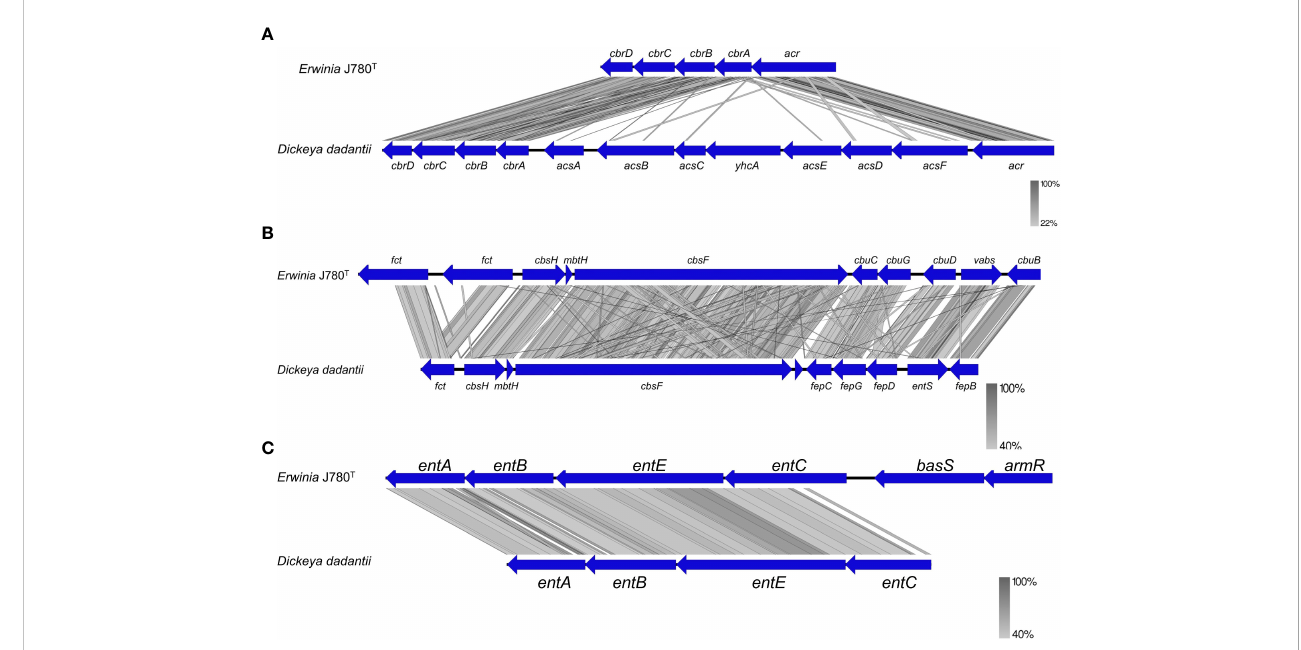
FIGURE 4 The comparison of siderophores genes between E. sorbitola sp. nov. (J780T) and Dickeya dadantil. (A) The comparison of achromobactin gene clusters; (B) the comparison of chrysobactin gene clusters; (C) the comparison of enterobactin gene clusters. The proposed gene nomenclature is shown above the corresponding ORFs. All the fi gures were compared using BlastX and pictured with Easy fi